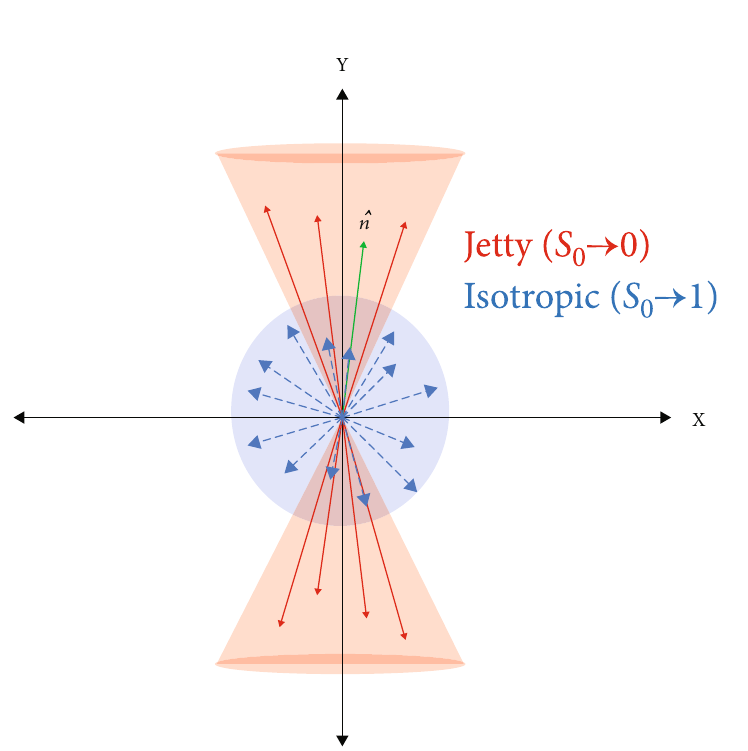
Figure 1: (Color online) Figure showing jetty and isotropic events in the transverse plane.